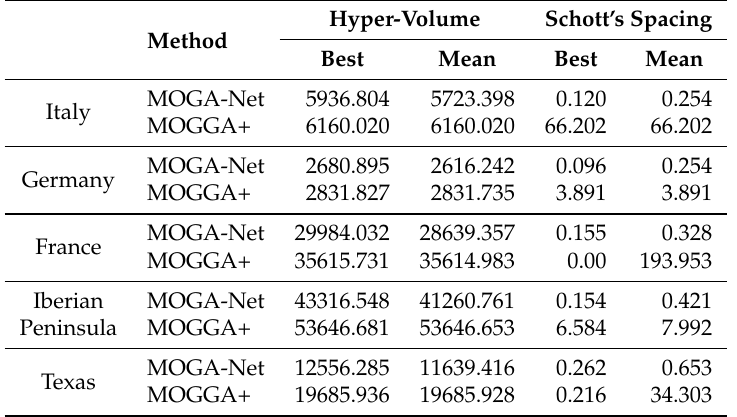
Table 4. Results obtained by MOGA-Net and MOGGA+ considering the conductance and imbalance